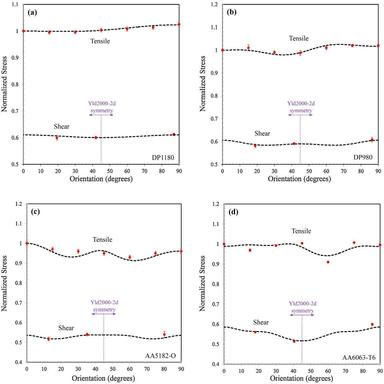
7. Normalized stress in different orientations with respect to the reference direction for (a) DP1180, (b) DP980, (c) AA5182-O, and (d) AA6063-T6. Red symbols show the experimental data. The calibration was performed with an emphasis upon obtaining best agreement with the shear stress which is required to obtain the hardening response from the shear test data. For orthotropic-symmetric materials, normalized shear stress is symmetric about the 45° orientation.